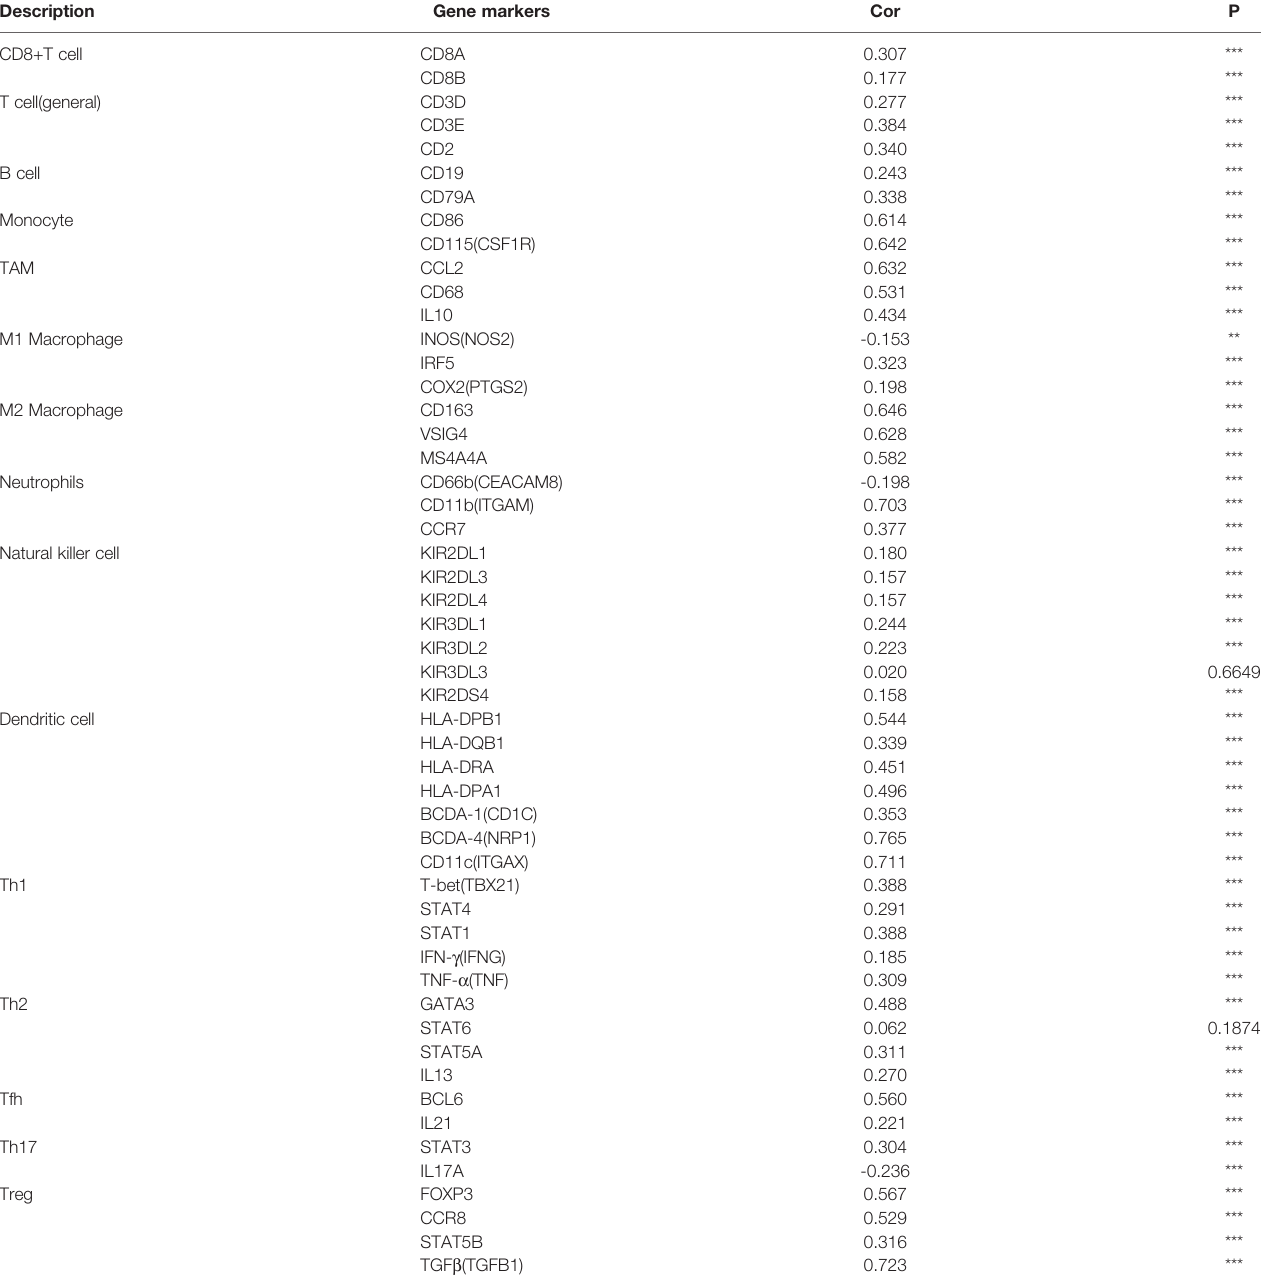
TABLE 2 | Correlation analysis between BGN and related surface markers of immune cells.